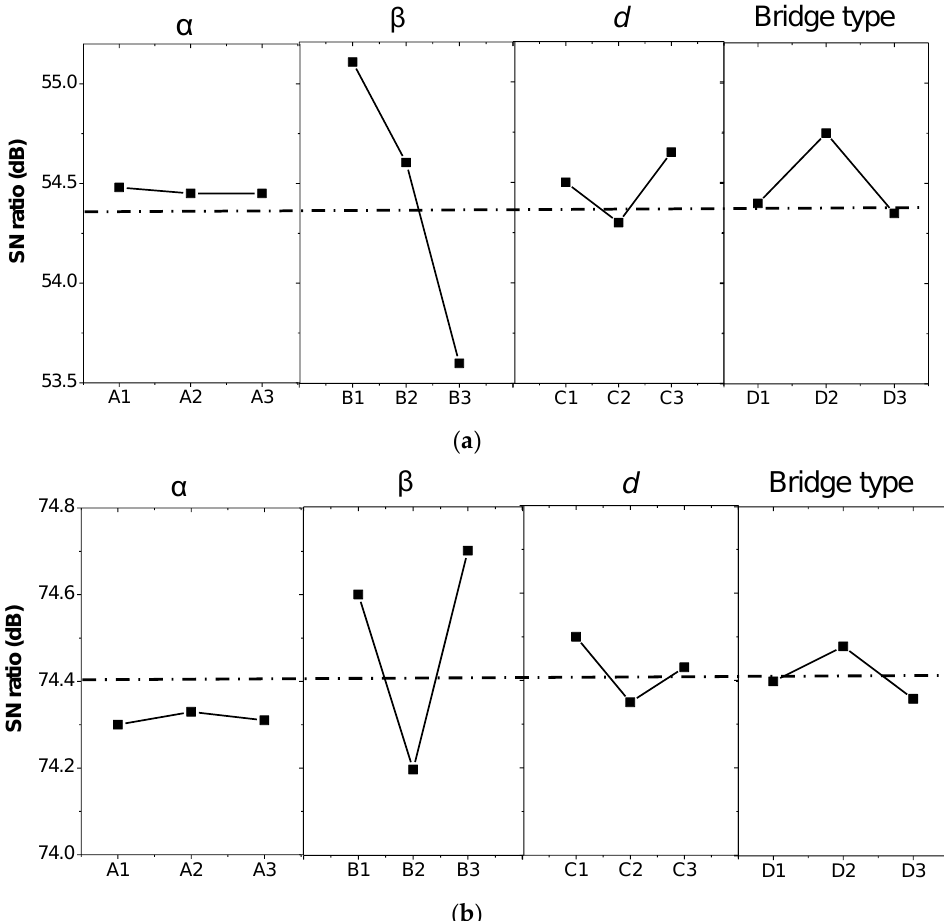
Figure 10. The SN (Signal-to-Noise ratio) ratio values of four shape parameters for ( a ) MMD (maximum mandrel deflections) and ( b ) SDV (axial direction).